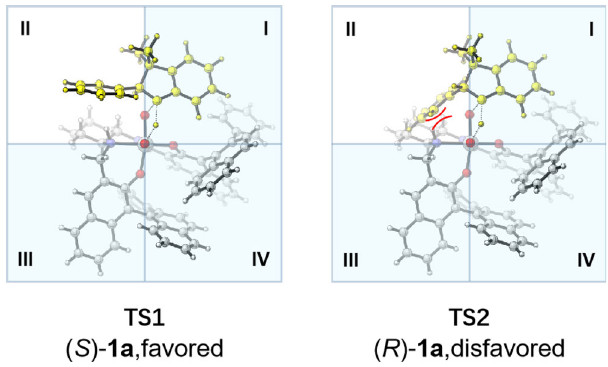
Fig. 9 Proposed transition state models. The transition state TS1 for ( S )- 1a is favored. The transition state TS2 for ( R )- 1a is